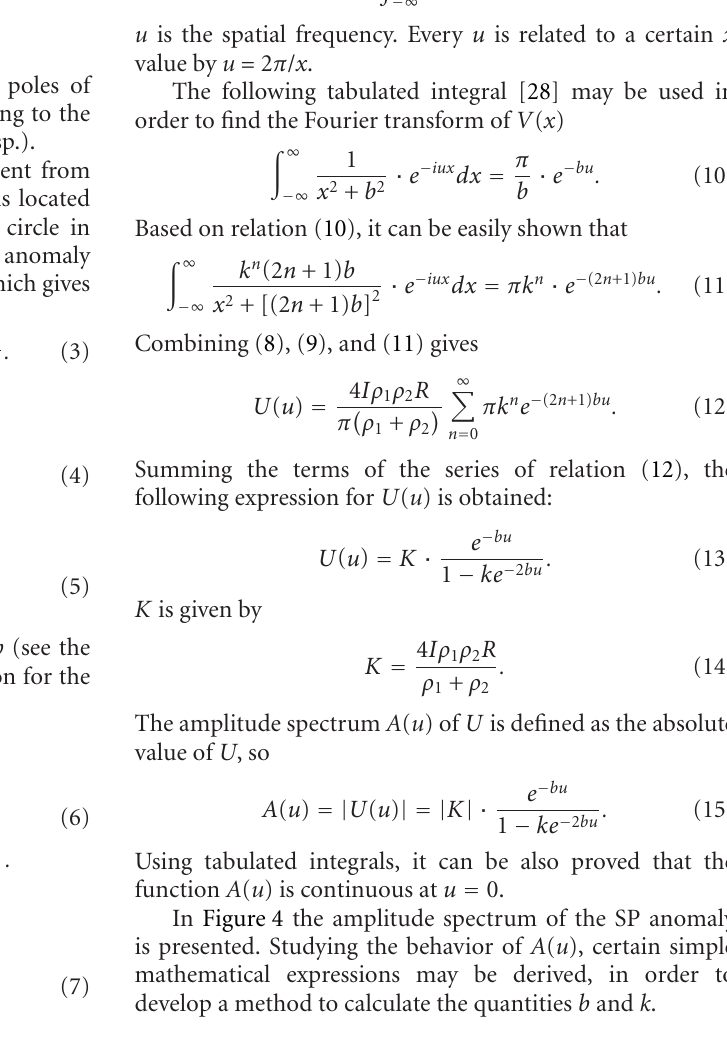
Figure 3: Representation of the SP anomaly produced by a polar- ized cylinder at the contact of two horizontal layers with di ff erent